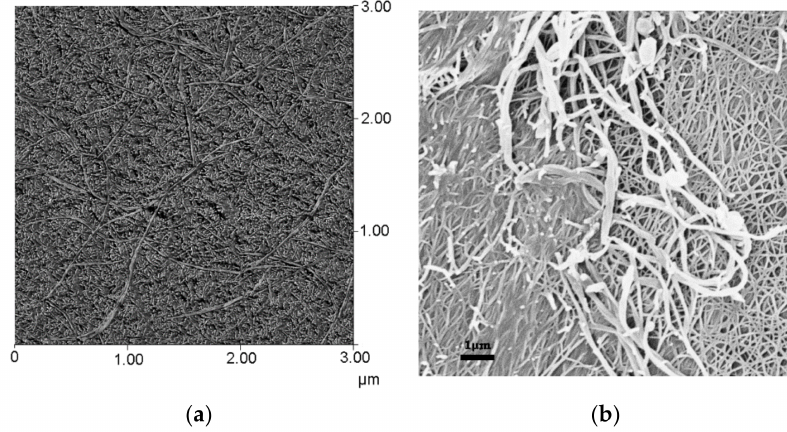
Figure 3. ( a ) AFM picture of an sPS/OPVOH gel in benzene by tapping mode [10]. ( b ) SEM picture of aa sPS/OPVOH gel in p-xylene (courtesy of Christophe Daniel, Universita di Salerno, Italy). In both